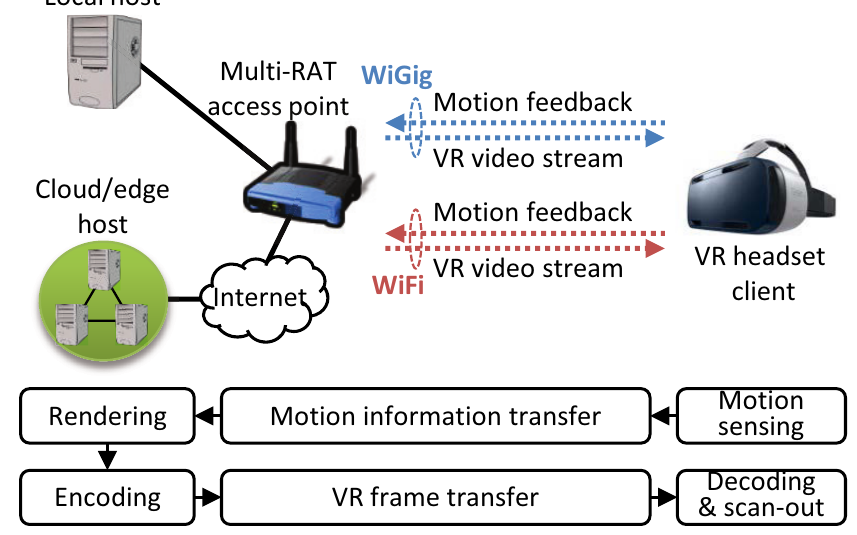
Figure 1. Multi-RAT wireless VR